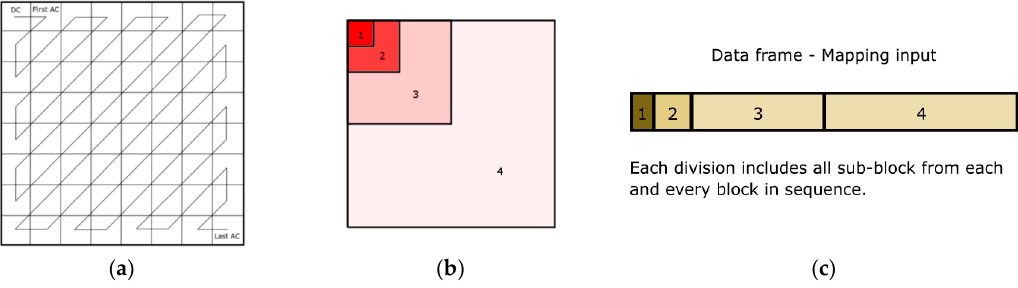
Figure 1. ( a ) The DCT is applied to each 8 × 8 pixel block. ( b ) Each 8 × 8 block is split into 4 sub-blocks in order to apply different analog mapping/transformation schemes. ( c ) Each sub-block is placed in a sequential data